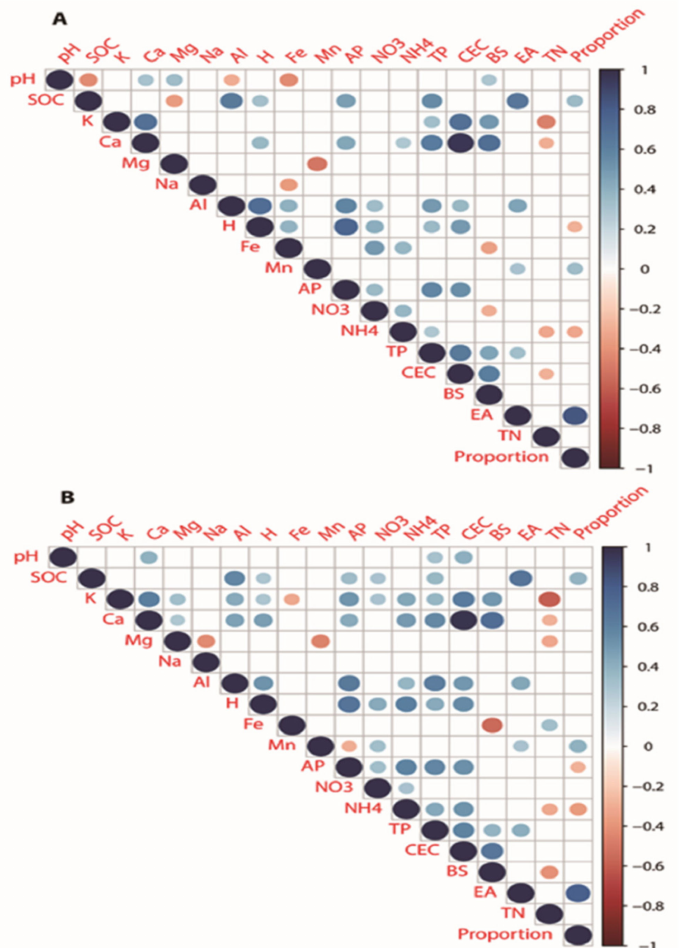
Figure 4. Heat map for Pearson’s correlation coefficients of soil aggregates and soil chemical proper- ties mixed broad-leaved Korean pine forest (BKPF) ( A ) and artificial Korean pine forest (KPP) ( B ) in Northeast (NE) China. The chemical properties were identified in each sample by circle size and colors deduced from − 1.0 to +1.0. Abbreviations: hydrogen ions (H + ); potassium ions (K + ); magne- sium ions (Mg 2+ ); manganese ions (Mn 2+ ); sodium ions (Na + ); calcium ions (Ca 2+ ); aluminum ions (Al 3+ ); iron ions (Fe 3+ ); effective cation exchange capacity (ECEC); base saturation percentage (BS%); effective acidity (EA); ammonium (NH 4 + -N); nitrate (NO 3 + -N); total nitrogen (TN); soil organic carbon (SOC); soil